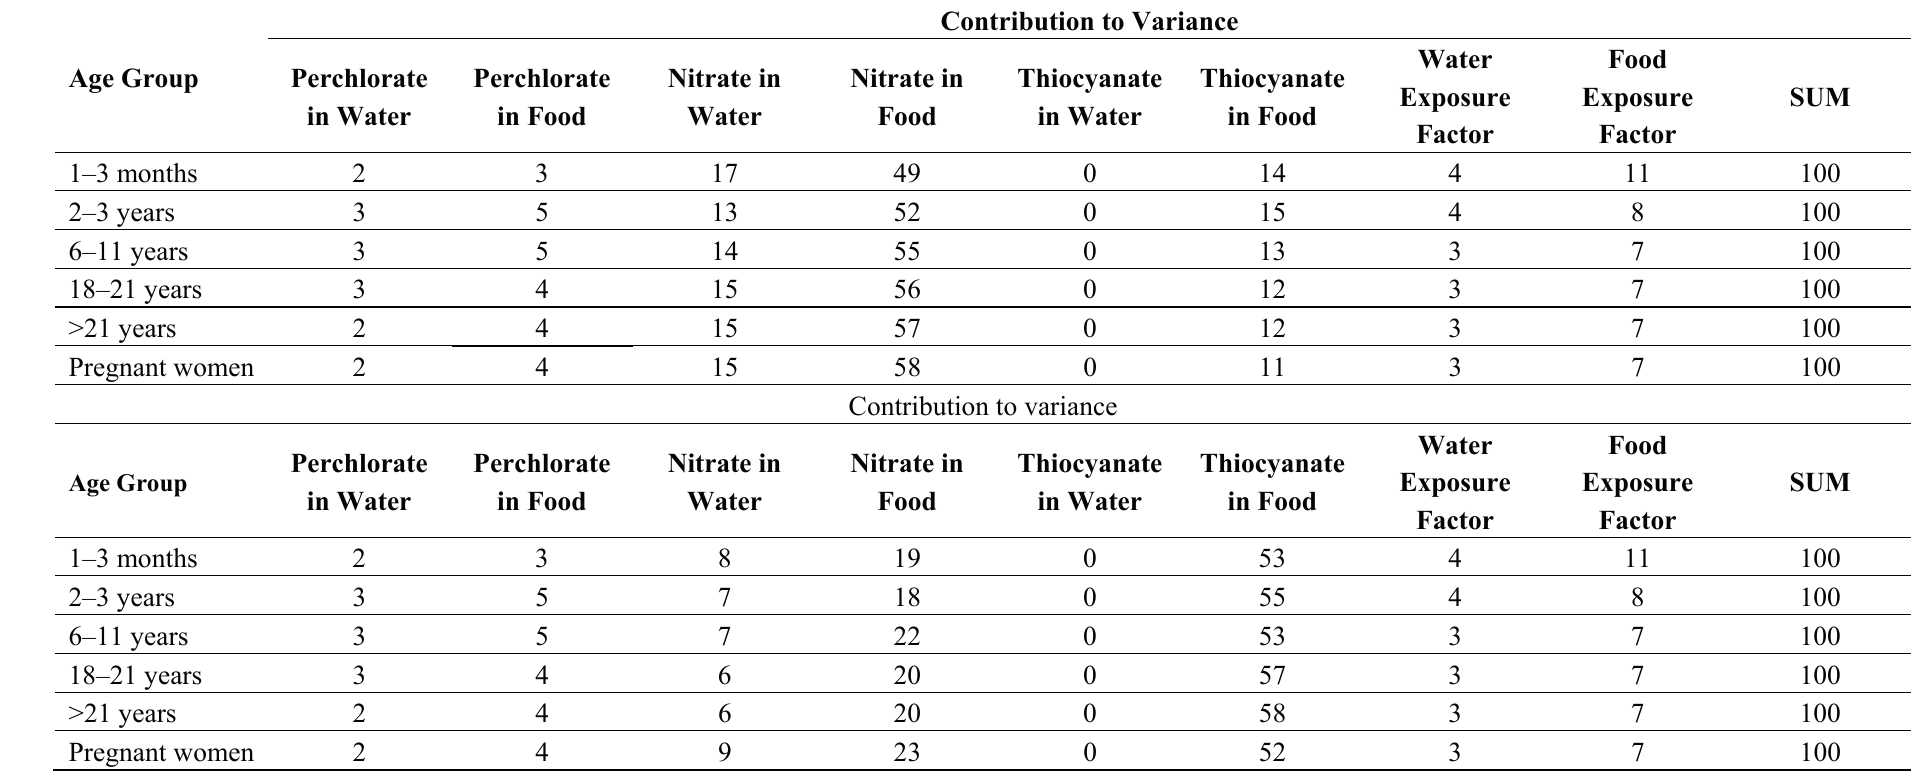
Table 3. Contribution to Variance results, showing the percentage of the inter-subject variation in ADRI associated with each of the indicated factors upper table contains the results without half-life correction, and the lower table presents the same results with half-life